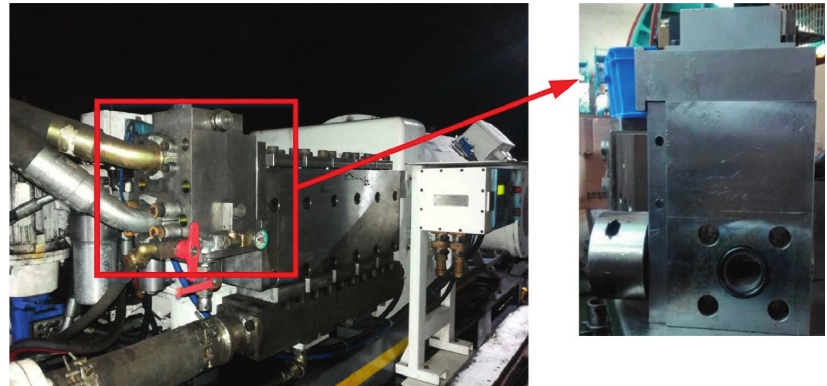
Figure 29: The physical structure of relief